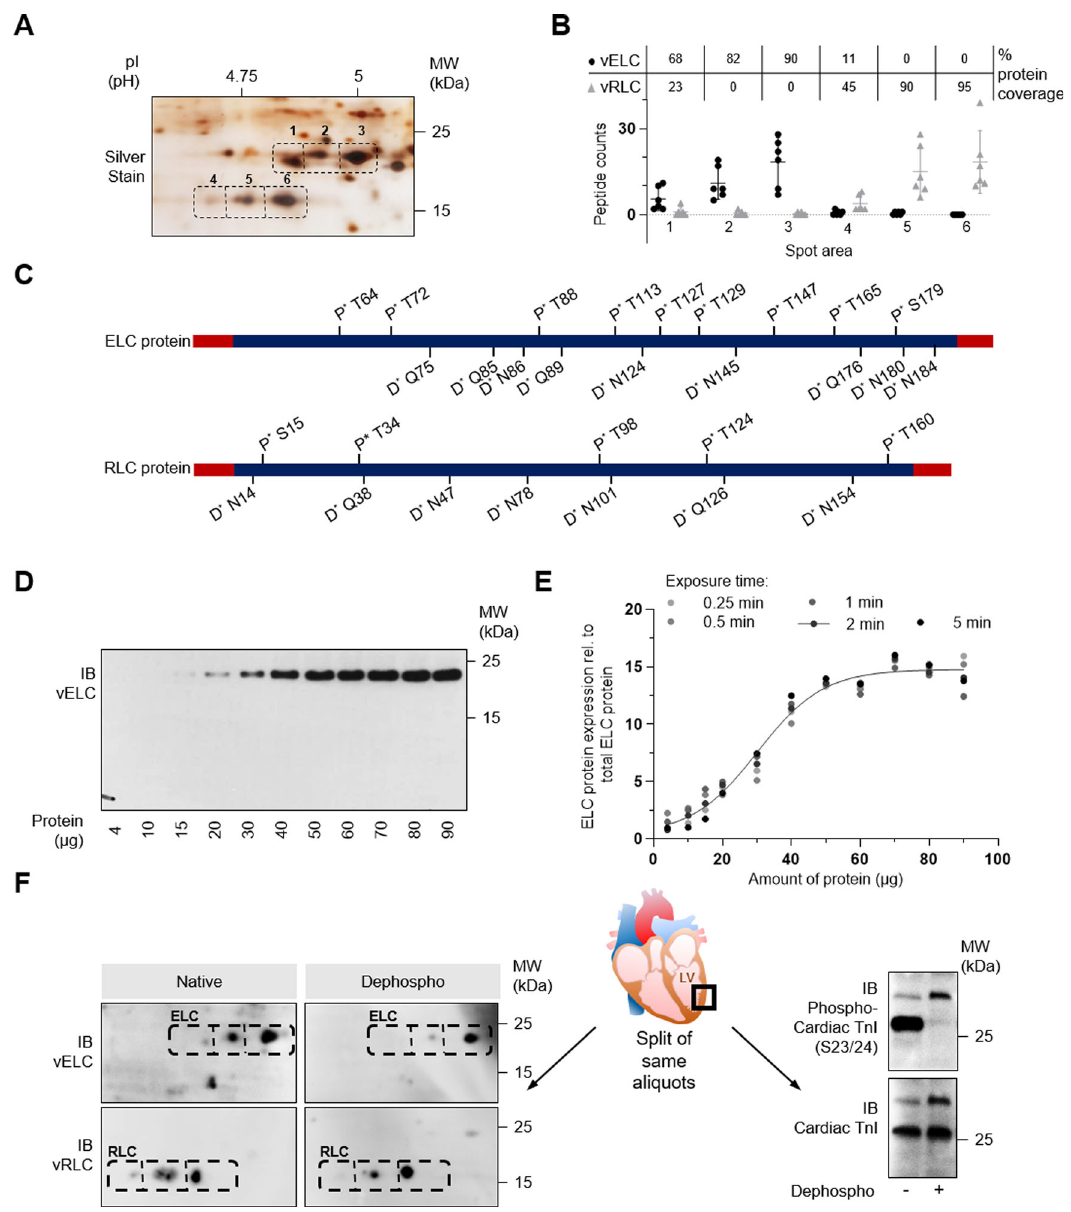
Fig. 7 | ELC posttranslational modi fi cations in human left ventricular tissue. A Representative 2D silver stain of human LV tissue. B Selected spot areas 1 to 6 were analyzed by liquid chromatography followed by mass spectrometry (LC-MS). Peptide counts uniquely assigned to ventricular (v) ELC or vRLC are shown for 6 independent samples. The mean percentage of the protein coverage of vELC and vRLC are given above (table inset). Data are mean±SD. C Schematic illustration of identi fi ed ELC or RLC-phosphorylation sites and deamidated amino acid residues detected in human LV tissue ( n =6; DCM: n =4; Ctrl: n =2). D Validation of poly- clonal rabbit antibody against human ELC (Biozol, GeneTex, ZF127578) by immu- noblot(IB)ofdifferentamountsofhumanLVprotein.NocrossreactivitywithvRLC was detected. E Quanti fi cation of relative ELC protein expression illustrated as averagedintensitynormalizedtototalELCprotein.ELCexpressionintensitieswere